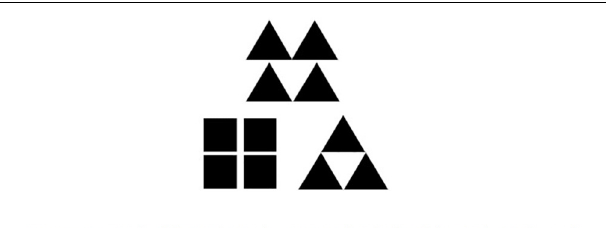
FIGURE 3 | Example Figures in the Figure Identification Task in Study